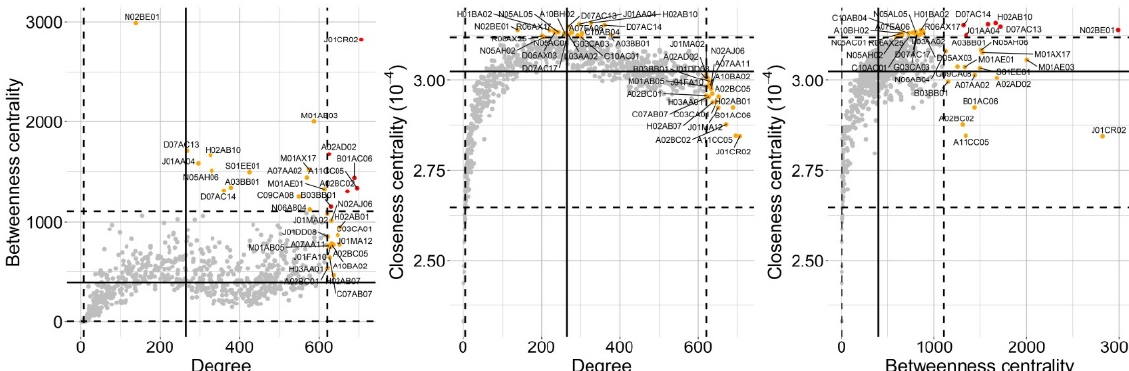
Figure 4. Node degree, betweenness centrality and closeness centrality. To better understand the relative importance of each node (DPN-ATCL5), degree, betweenness centrality and closeness centrality were computed and displayed in the 2D scatter plots. Horizontal and vertical black lines display the 50th (solid line), 2.5th and 97.5th (dashed lines) percentiles. Each node is represented as a dot; coloured (orange and red) dots highlight subsets of ATC codes endowed with the higher relative importance, with respect to the three metrics.